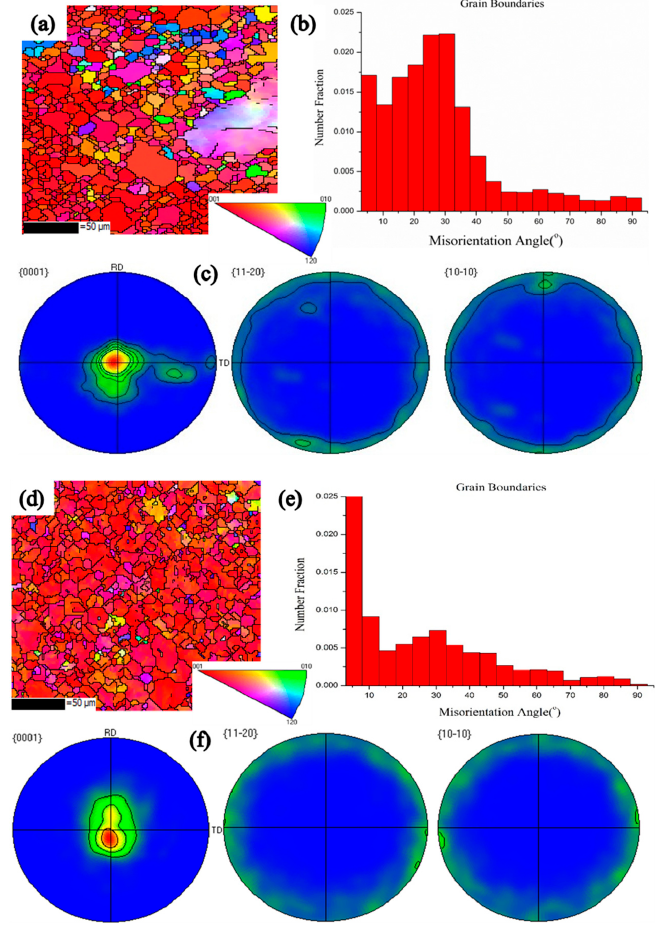
Figure 9. The orientation imaging maps of ( a ) as-extruded and ( d ) as-rolled sheets, the misorientation angle maps of ( b ) as-extruded and ( e ) as-rolled sheets, and pole figure maps of ( c ) as-extruded and ( f ) as-rolled sheets.